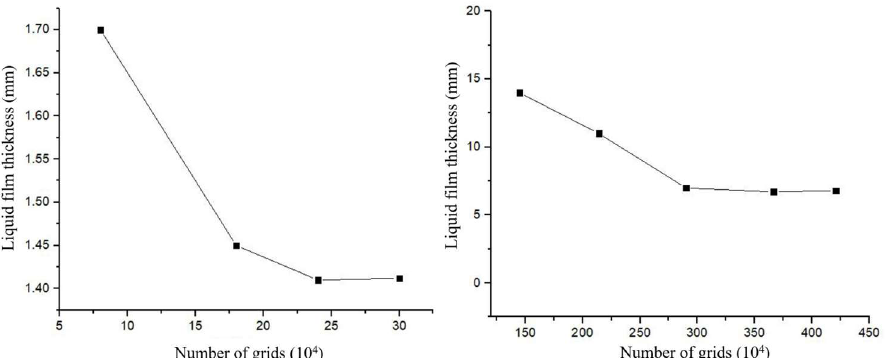
Figure 7. The grid independence analysis.